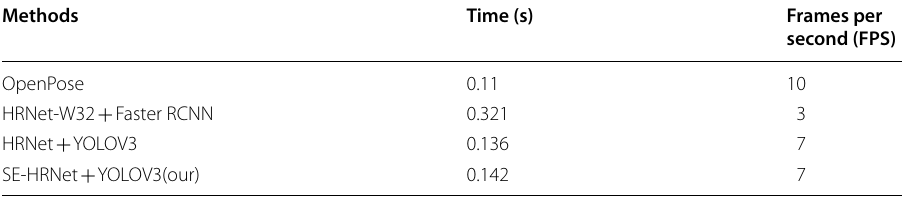
Table 3 Comparison of the processing time of different methods on the proposed